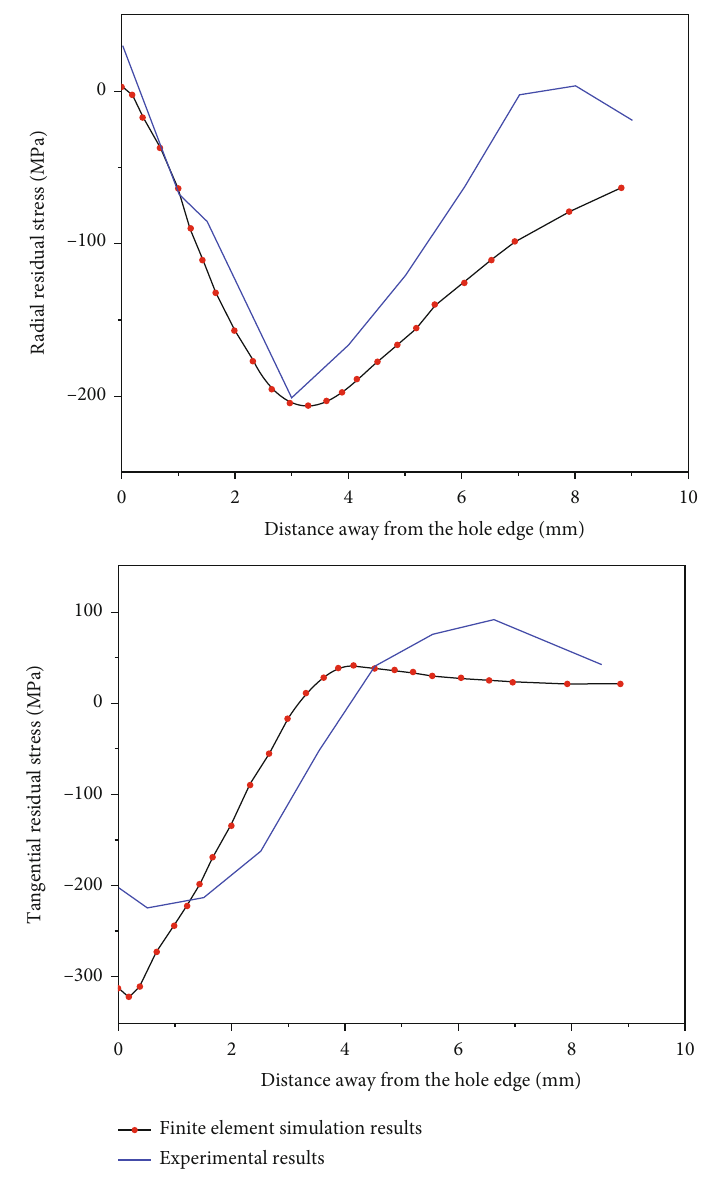
Figure 18: Experimental measurement and fi nite element simulation of residual stress.